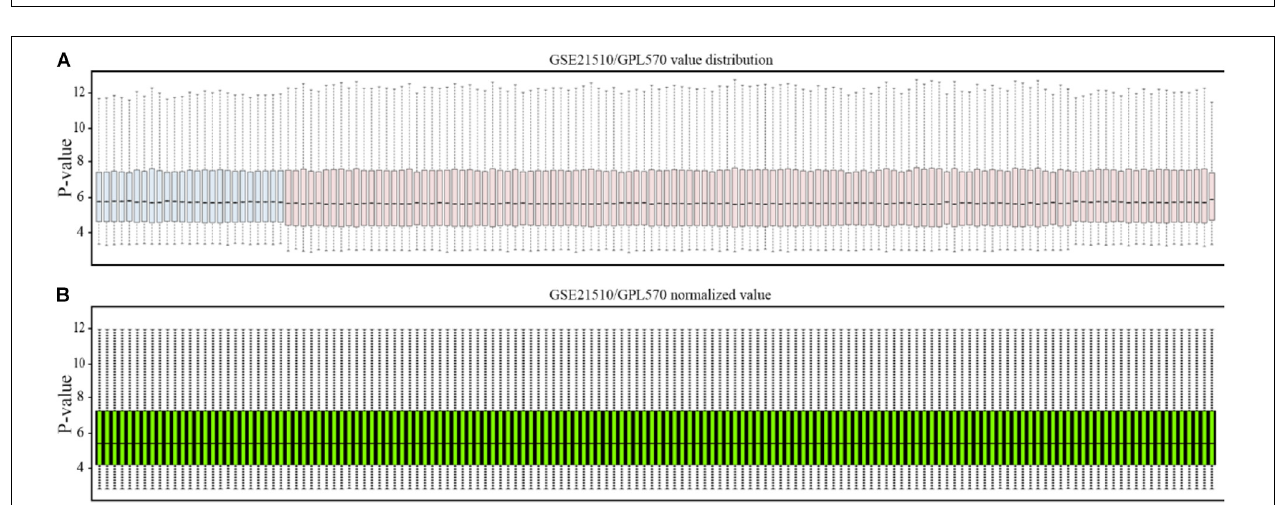
FIGURE 2 | Normalization of gene profiling data. (A) Distribution of GSE21510 gene profiling data. (B) Value-normalized distribution of GSE21510 gene profiling data.